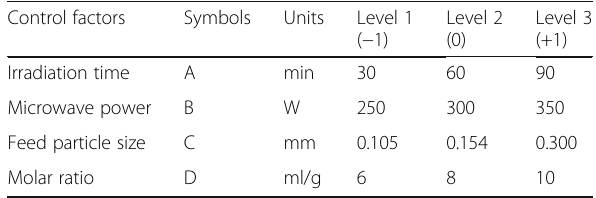
Table 1 Extraction factors and